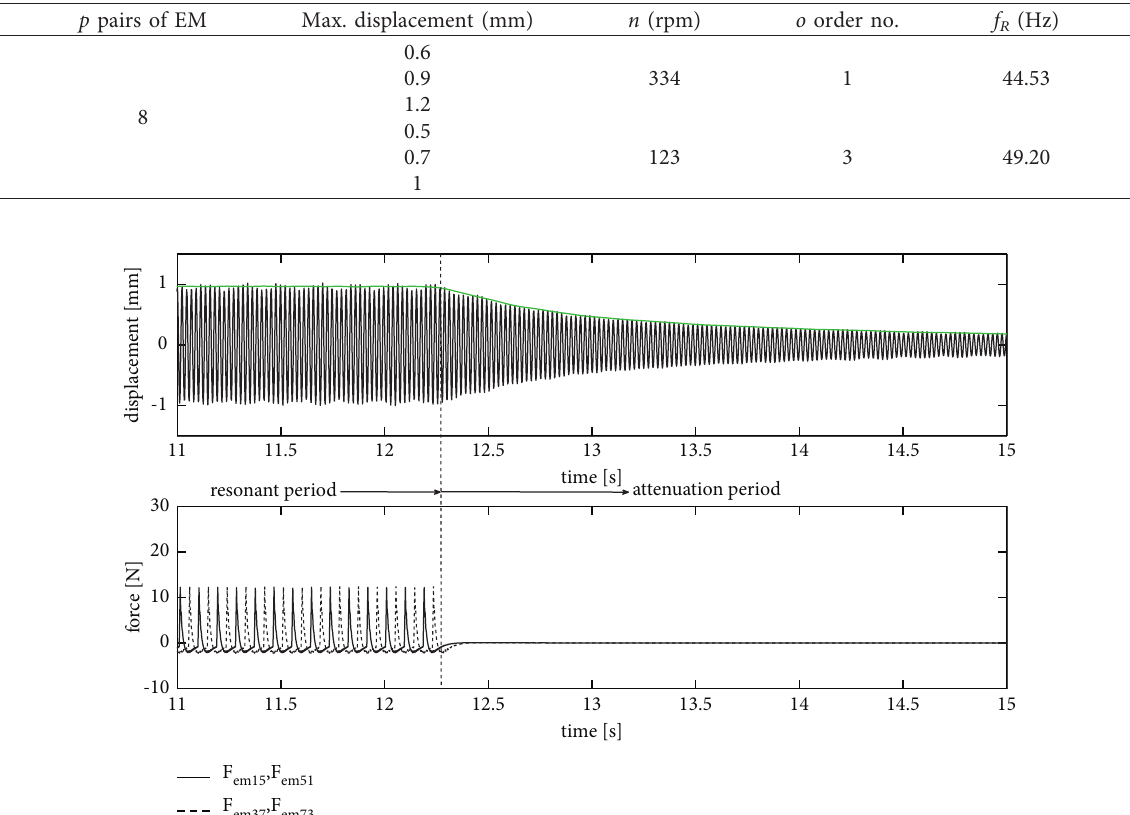
Figure 7: Vibration attenuation: mode 2ND, 331rpm—open contacts. Figures 7 and 8(a) are reproduced from